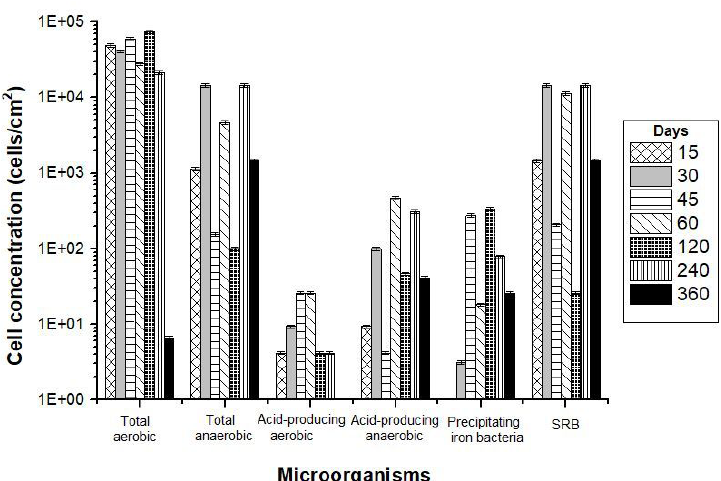
Figure 3. Cellular concentration of sessile microorganisms quantified by the Colony Forming Unit (CFU) and Most Probable Number (MPN)